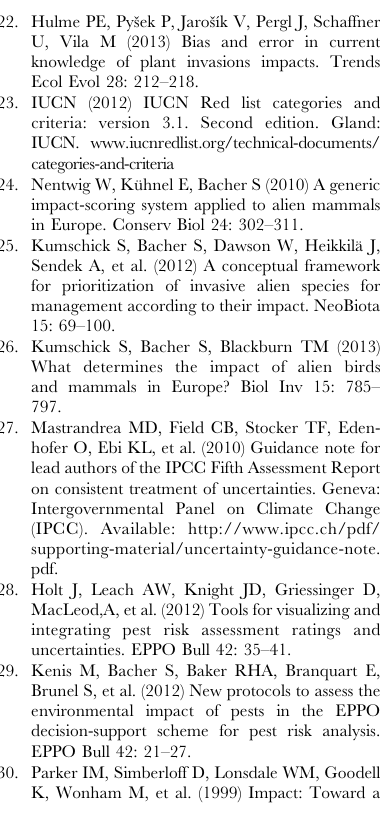
Table S1 Guidance regarding